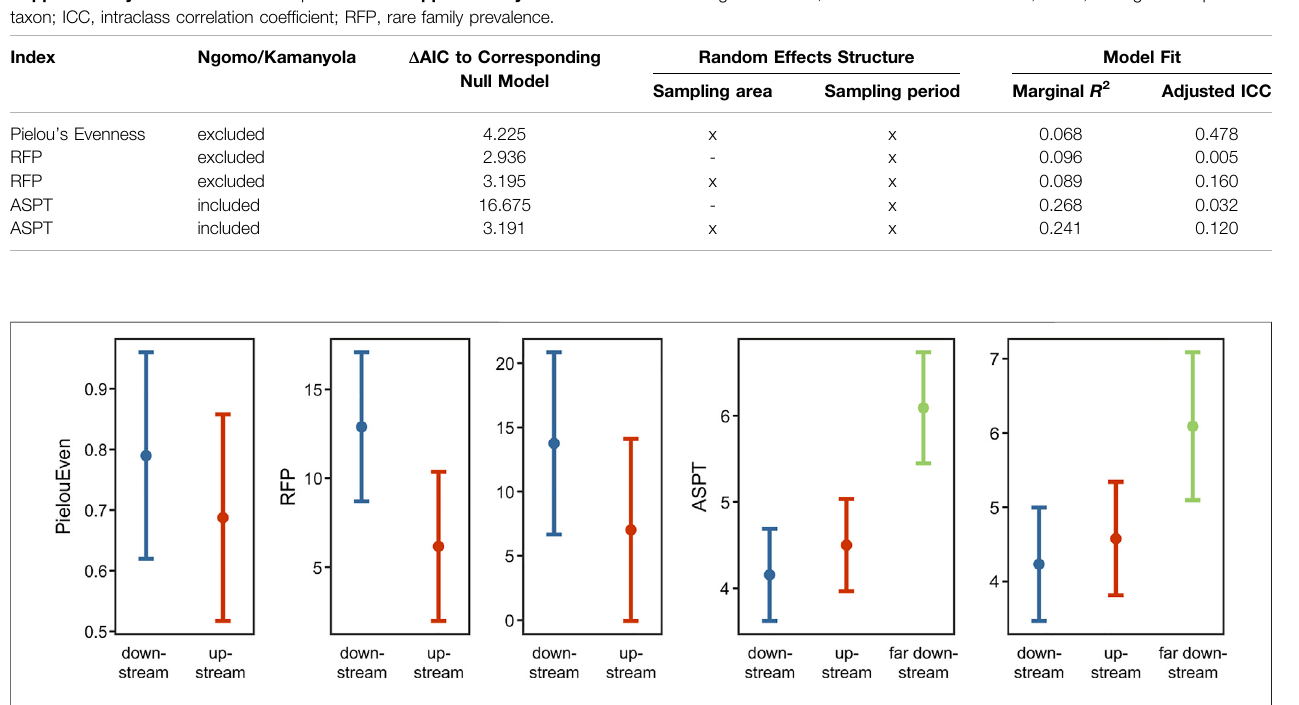
Frontiers in Environmental Science |